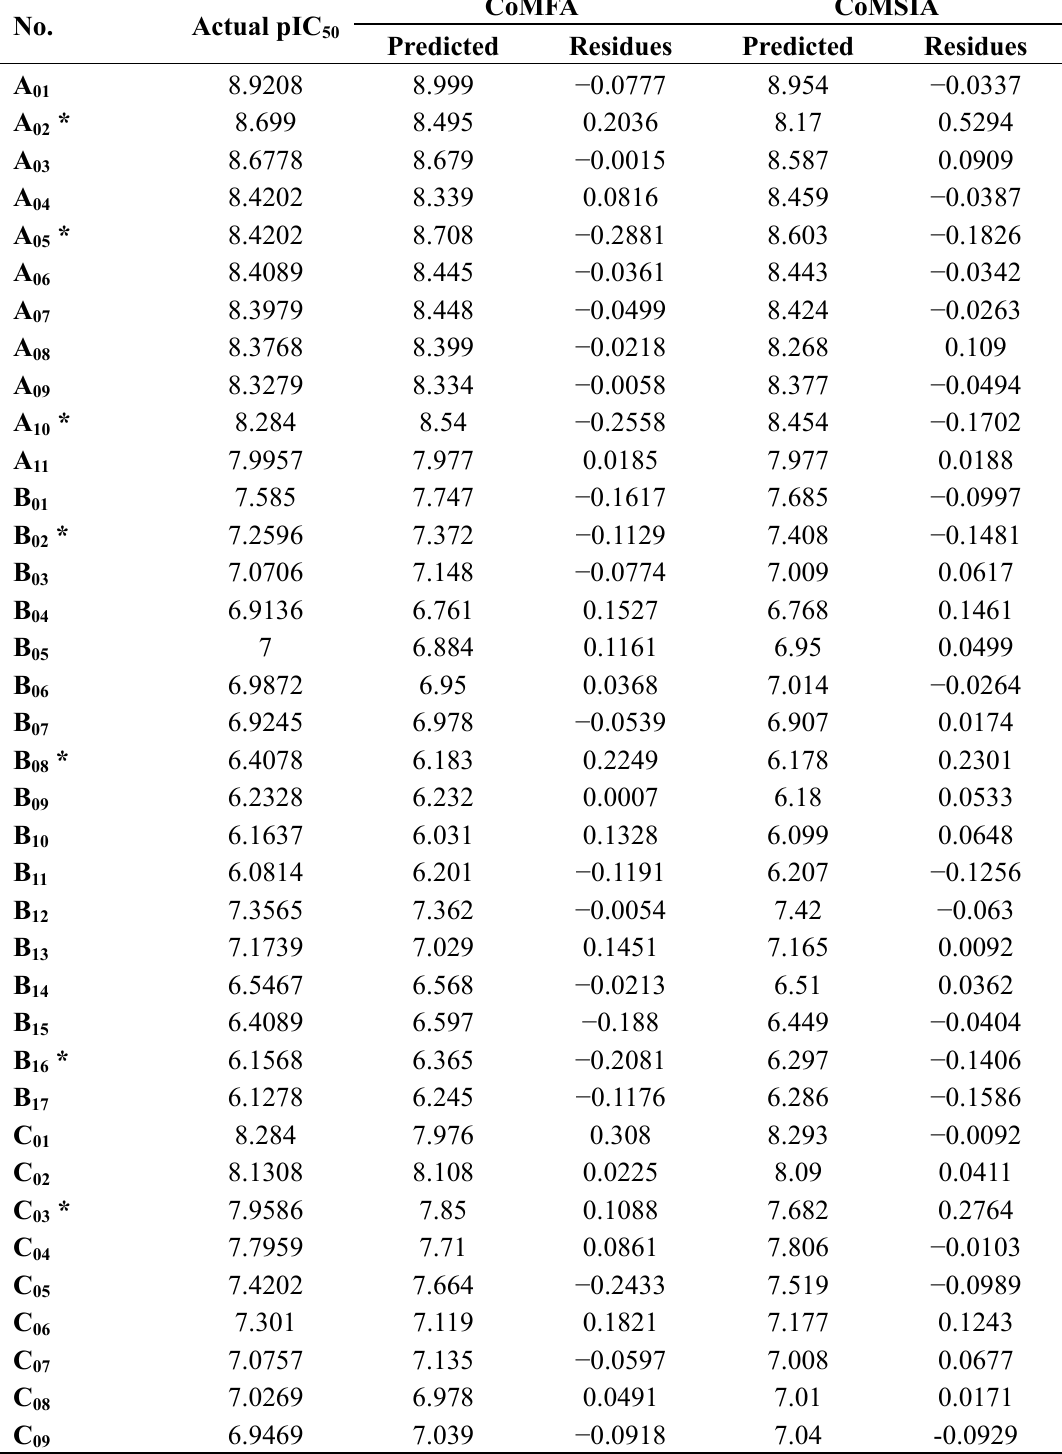
Table 3. Comparison of experimental activities (pIC50 values), predicted activities (pIC50 values) and residual values of all the 37 inhibitors were shown in the CoMFA and CoMSIA